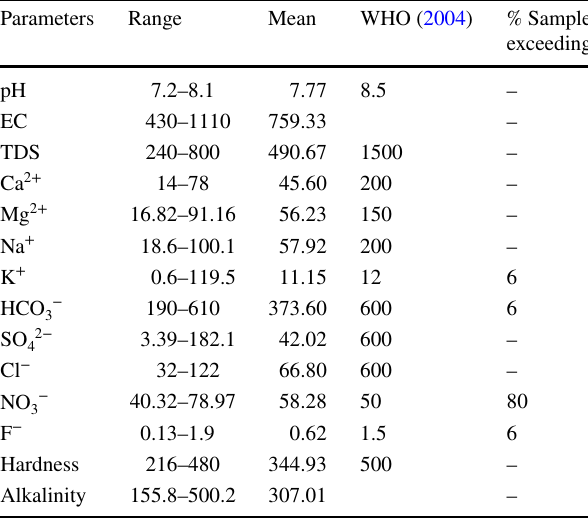
Table 2 Statistical summary of physicochemical parameters and its comparison with WHO standards for groundwater